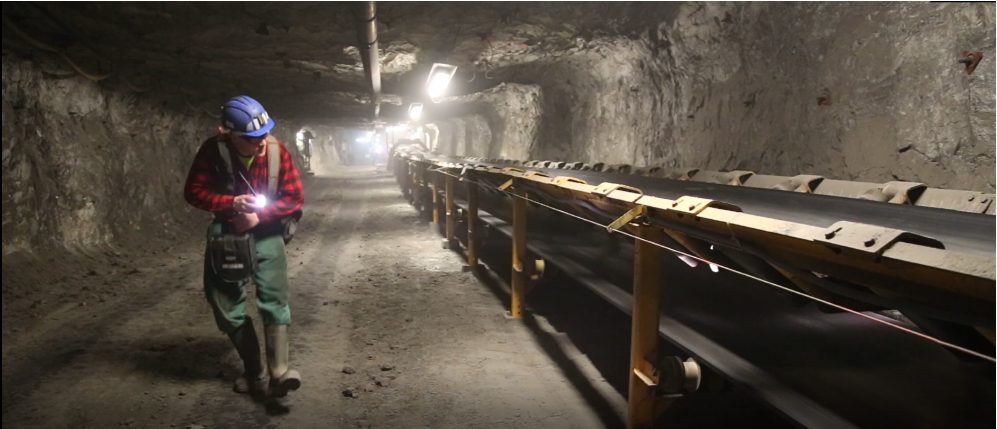
Figure 5. Conveyor belt route inspection